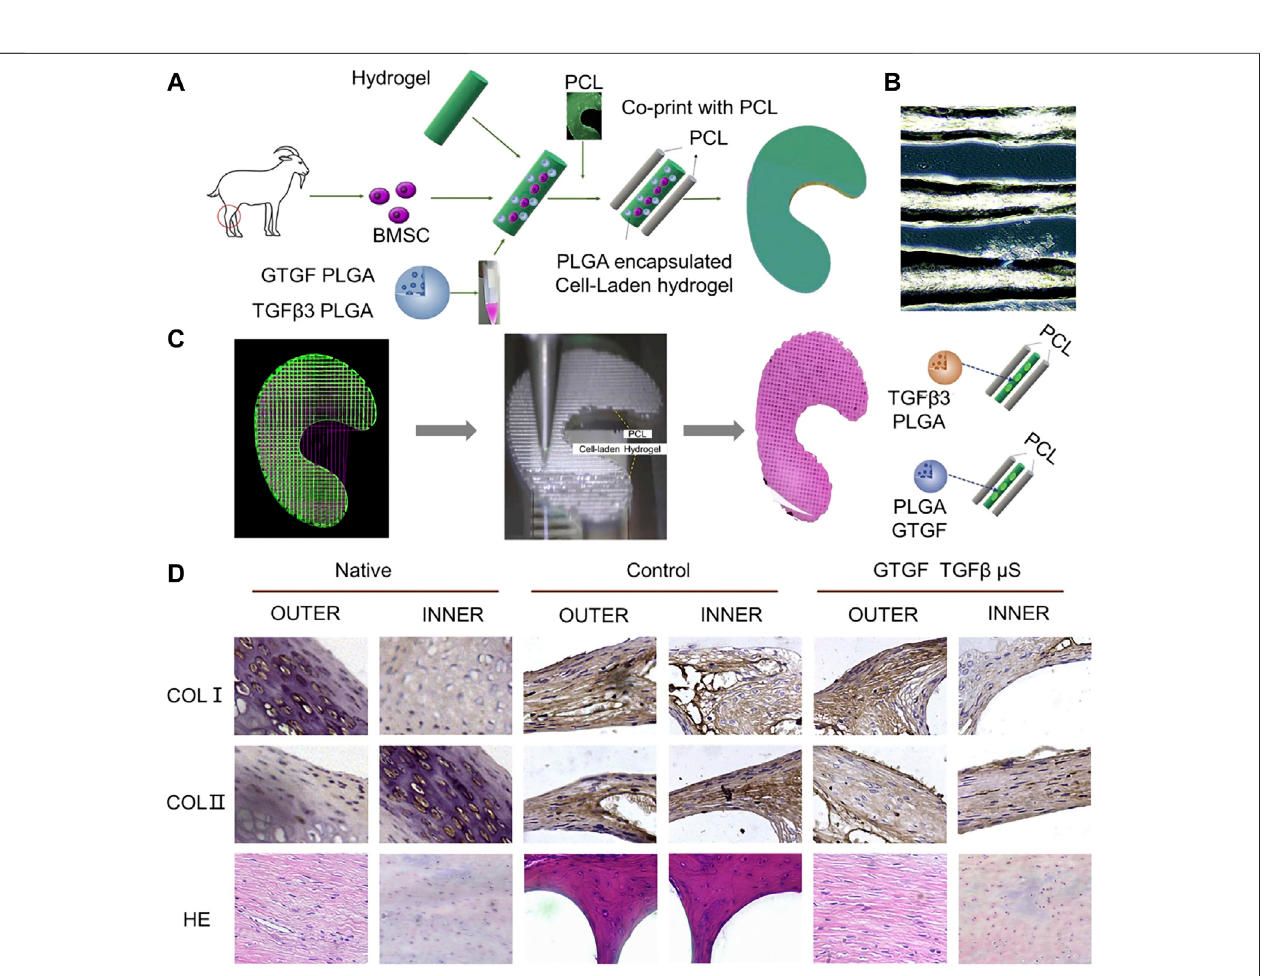
FIGURE 7 | PCL and PLGA encapsulated cell-laden hydrogel was used to make a meniscus scaffold by 3D printing technology. (A) Schematic diagram of the design of a bioprinted composite material study for regeneration of a goat meniscus. (B) PLGA-encapsulated hydrogels containing MSCs cells exhibited good printability. (C) CADmodelofthemeniscusfor3Dprinting.ThecellhydrogelandPCLwereprintedinto3Dmeniscusby3Dprintingtechnology. (D) Zone-speci fi cmatrix phenotype analysis in engineered versus native tissue (Sun et al.,